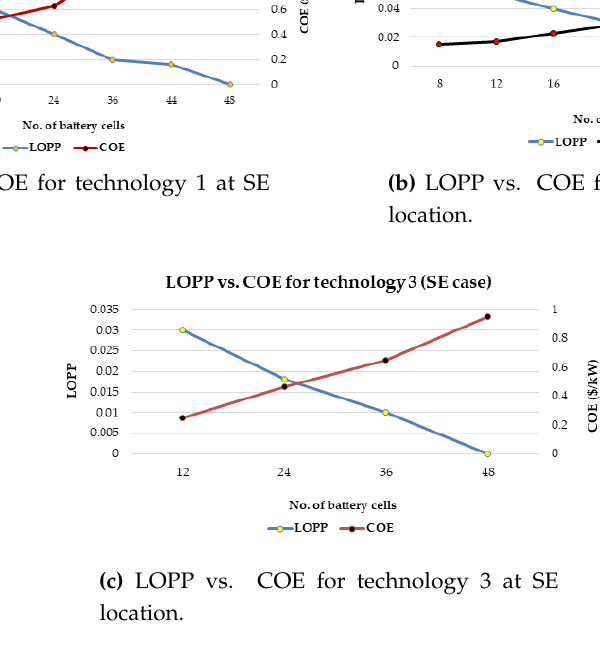
Figure 15. Technology selection for SE